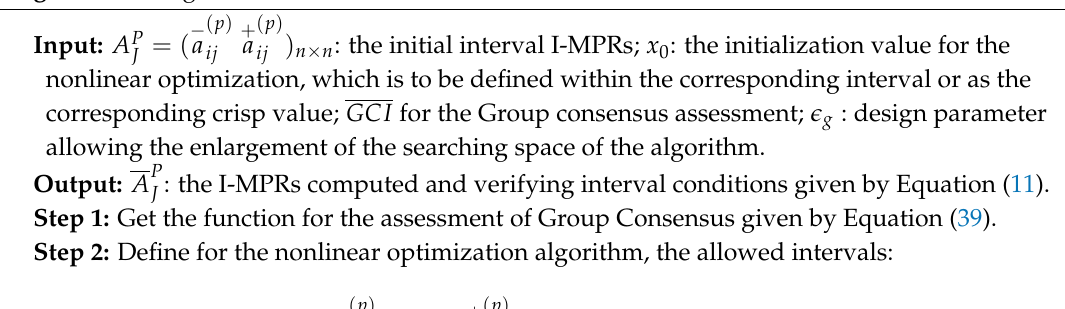
Algorithm 2: Algorithm